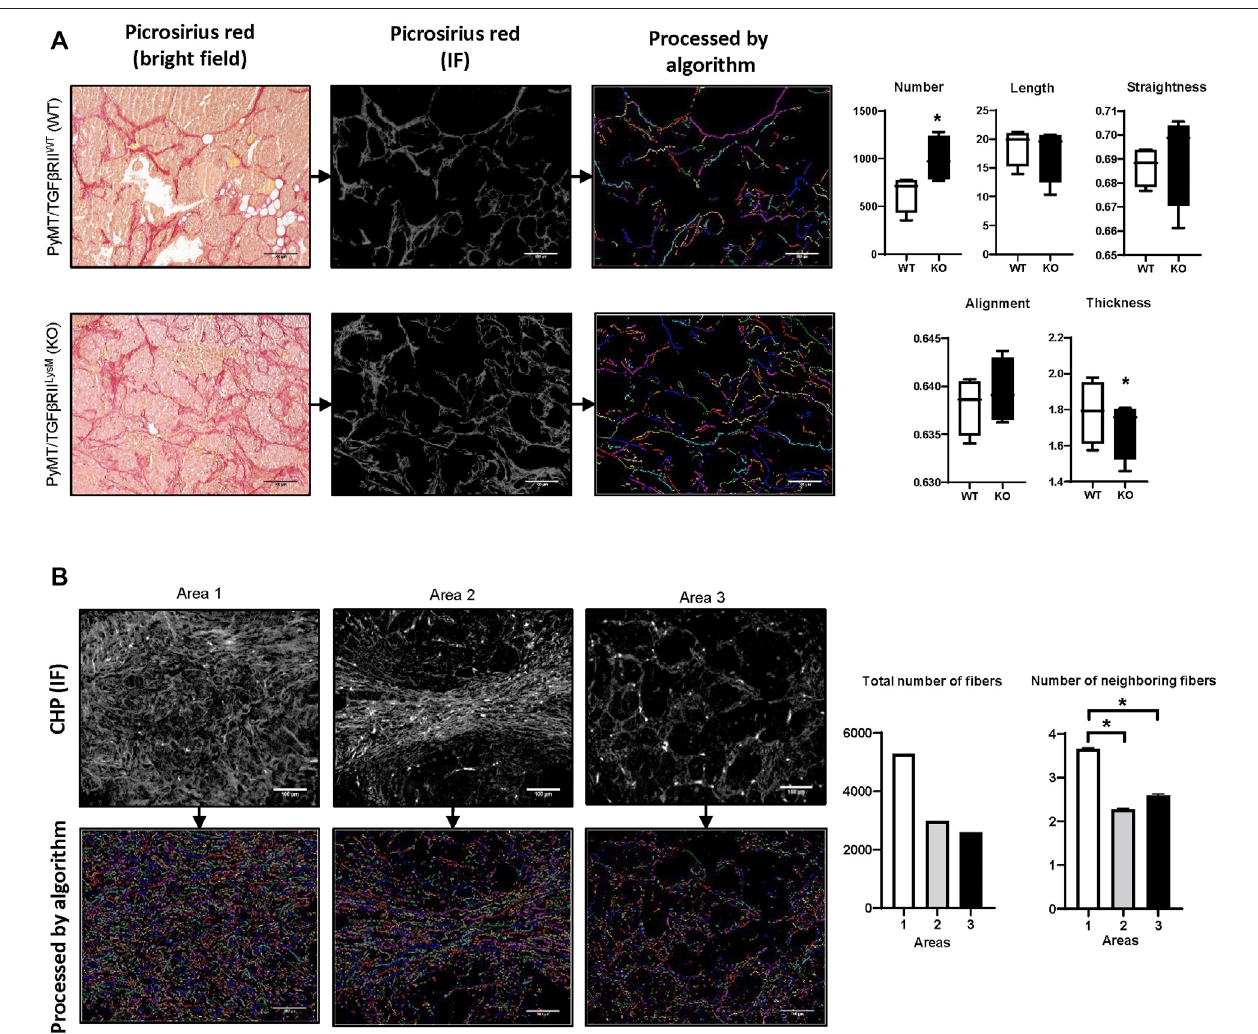
FIGURE 3 | Examples of algorithm usage. (A) Implementation of module for fi ber geometrical analysis of PyMT mouse mammary tumor tissue from WT and TGF β RII KO groups (Vasiukov et al., 2020). Collagen fi bers were visualized using Picrosirius red staining. Length, width, straightness, and alignment were calculated for each fi ber and presented as average. * – p < 0,05. Image size – 1920 x 1440, scale bar — 100 μ m. (B) Implementation of modules for fi ber labeling and spatial analysis for human breast cancer tissue stained by CHP-Cy3 (3Helix, United States). Number of neighboring fi bers was calculated as total number of fi bers